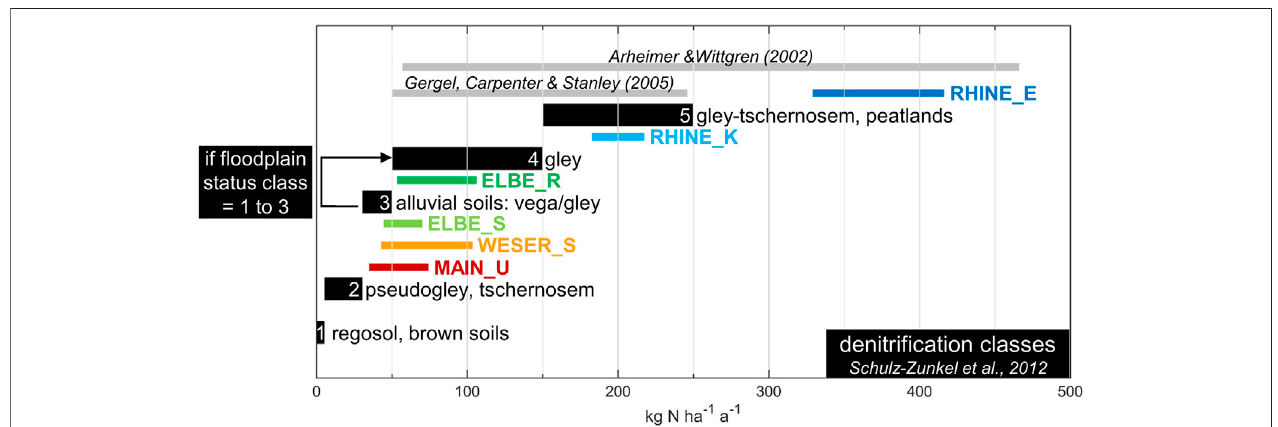
FIGURE 6 | Assessment of nitrogen retention via denitri fi cation classes after Schulz-Zunkel et al. (2012) in kg N ha − 1 a − 1 . If fl oodplain status class (FlStC) (cid:2) 1, 2, or 3 denitri fi cation class (DC) raises from 3 to 4. This is compared with observed average values by two other studies, and observed mean potential fl oodplain denitri fi cation capacitiesofElbe_R(ER),Elbe_S(ES),Weser_S(WS),Main_U(MU),Rhine_K(RK),andRhine_E(RE).Forthelatter,therangeplottedextendsfromtheupscaledmean,based on the average days of inundation over the past 5 years, to the upscaled mean, based on the average days of inundation over the past 30 years (see also Panel 5 ).